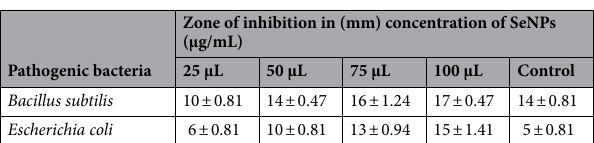
Table 1. Rapid synthesized SeNPs antibacterial activity against clinical